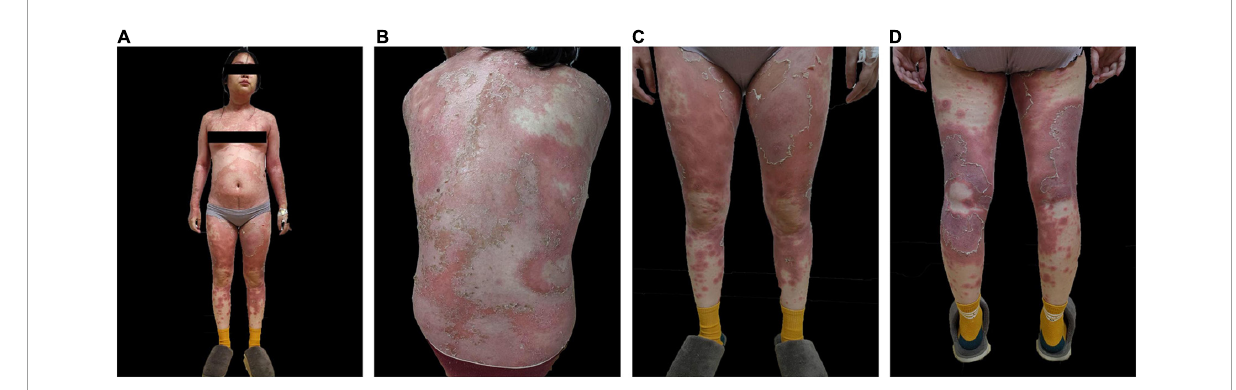
FIGURE1 Pre-treatment skin images of (A) anterior skin lesions (B) posterior skin lesions (C) anterior lower extremities (D) posterior lower extremities.